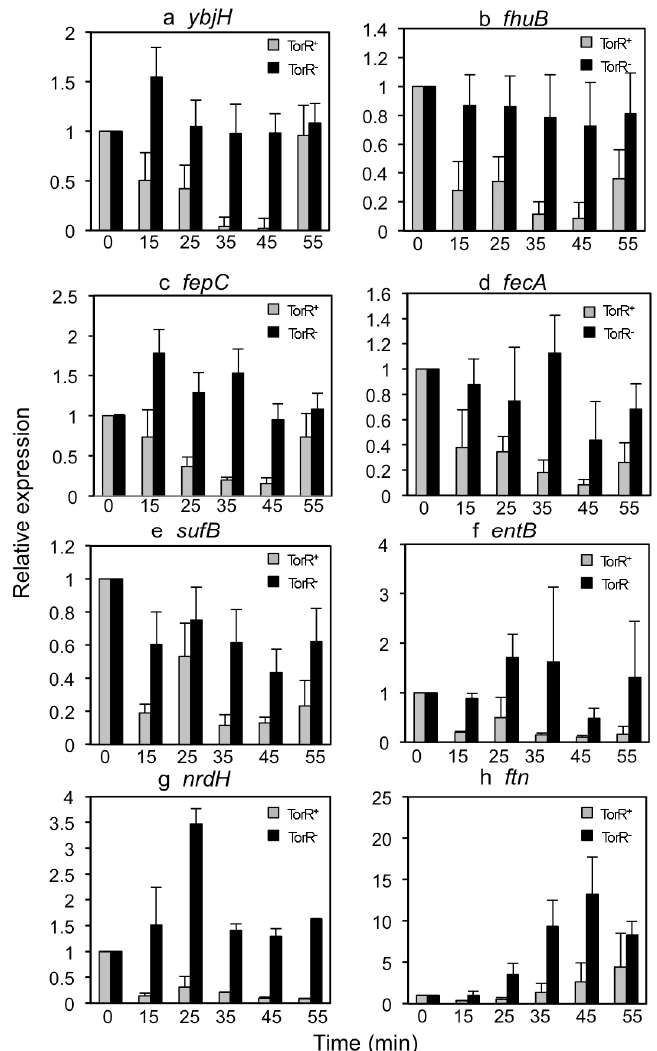
Figure 3. Cell-cycle-dependent co-localization of TorR-GFP focus with the nucleoid affecting expression of several genes. Synchronization, induction of TorR-GFP expression, and preparation of W3110 ∆ torRdnaC2 cells carrying pTorR-GFP were as described in the legend of Figure 2. Total RNA isolation, complementary DNA (cDNA) synthesis and performance of reverse transcriptional quantitative PCR (RT-qPCR) were as described in Materials and Methods. Each gene expression was normalized using the Ct value corresponding to the E. coli rplO gene as an internal reference and the relative expression at every time point to the 0 min was calculated. The expression values are the mean of three individual experiments and the standard errors are given as the error bars. The X-axis indicates the time intervals after shift-down of the culture to the permissive temperature (30 ◦ C) and the Y-axis represents the relative expression of each gene. The grey bars are for expressions of genes in the cells with TorR-GFP and the black bars are for that in the cells without TorR-GFP. The values are the average of three experiments. The error bars are as indicated. All the genes analyzed are as indicated ( a – h